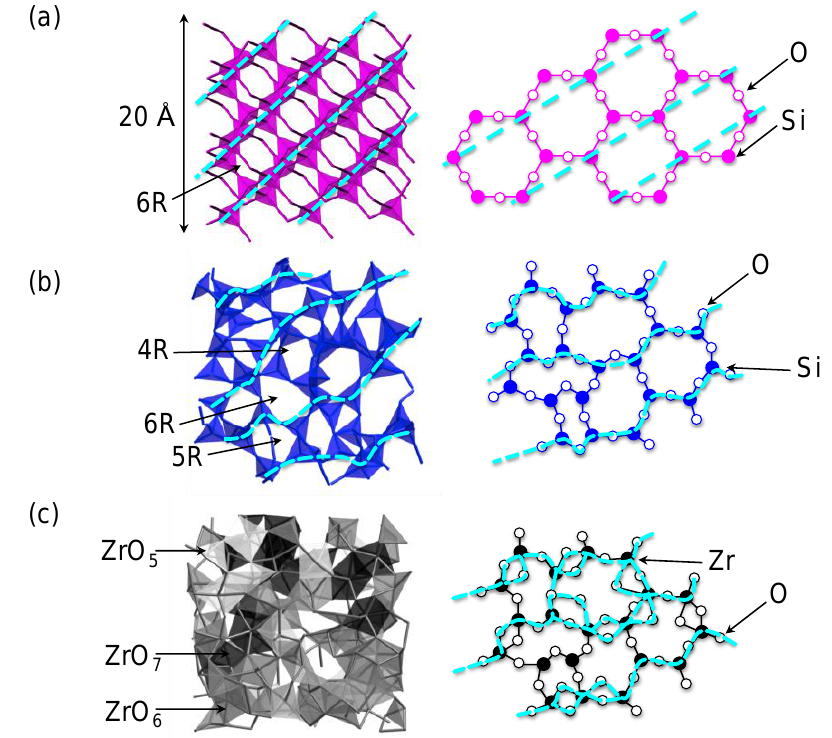
Figure 5. Atomic configurations and schematic illustrations of ( a ) c -SiO 2 , ( b ) l -SiO 2 and ( c ) l -ZrO 2 . The periodicity of the cage boundaries is highlighted by dashed lines and curves [7].